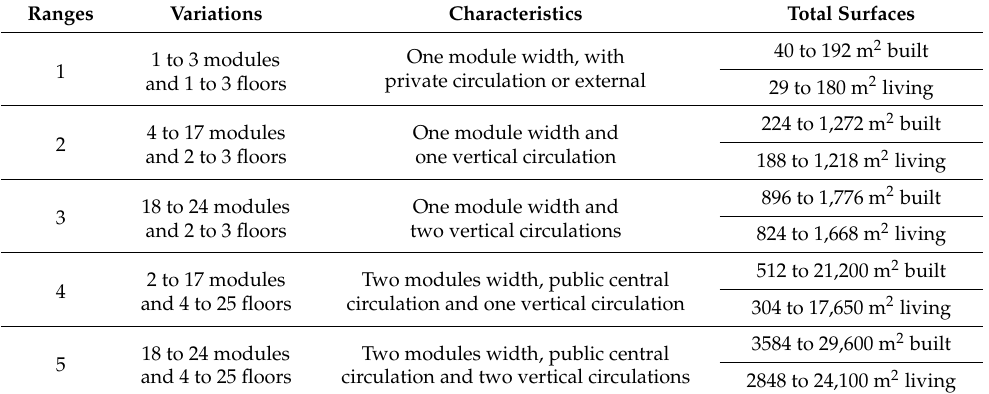
Table 2. Design Conditions of the Building Volumes.